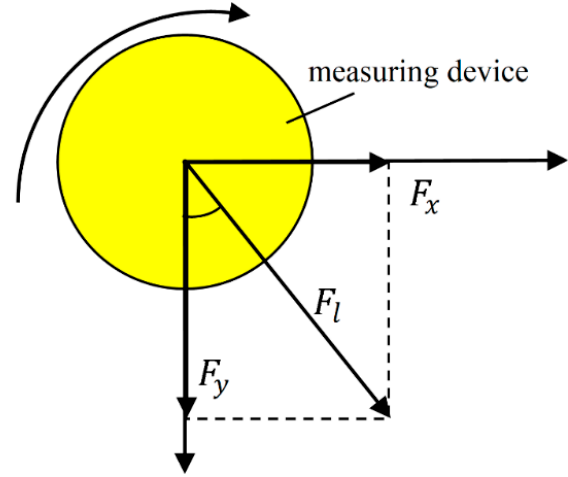
Figure 3. Synthesis of lateral force.